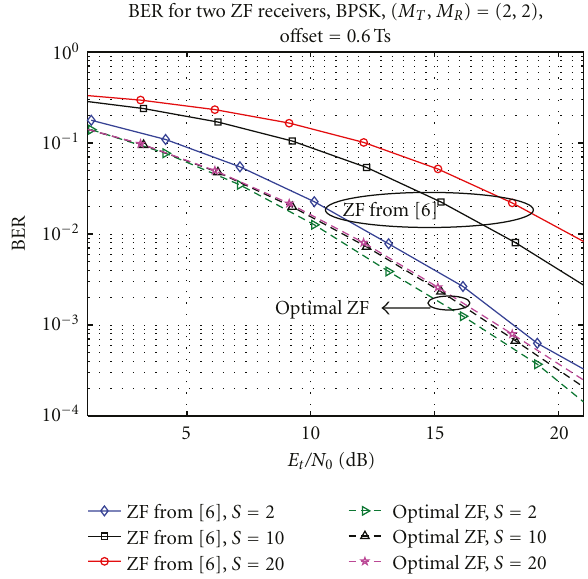
Figure 15: Optimal ZF receiver versus ZF receiver from [8].